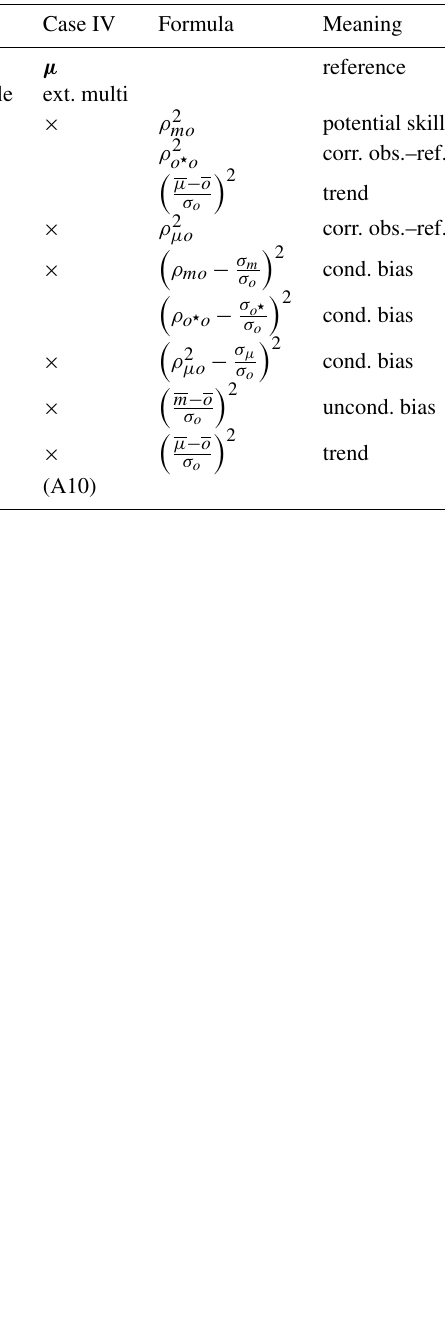
Table A2. Summarised skill scores S ( m , r , o ) based on the MSE (Cases I–IV) and relating terms (AI–CIV) as described in Sect. A3. m denotes the prediction model, r is the reference, and o denotes the observation. The “ × ” sign marks if a term (AI to CIV) appears in the different factorisations. The following abbreviations are used: corr. for correlation, obs. for observation, ref. reference (forecast), cond. for conditional, int. for internal, and ext. for external.